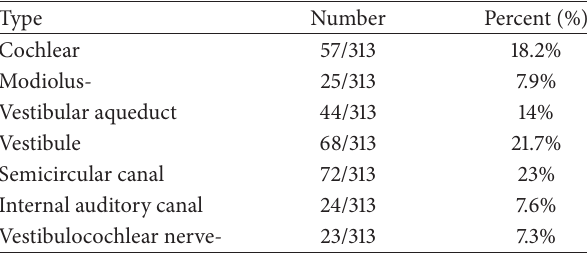
Figure 6: MRI scan of inner ear with axial section showing bilateral hypoplastic vestibulocochlear nerves. Table 1: Overall evaluation of malformations.